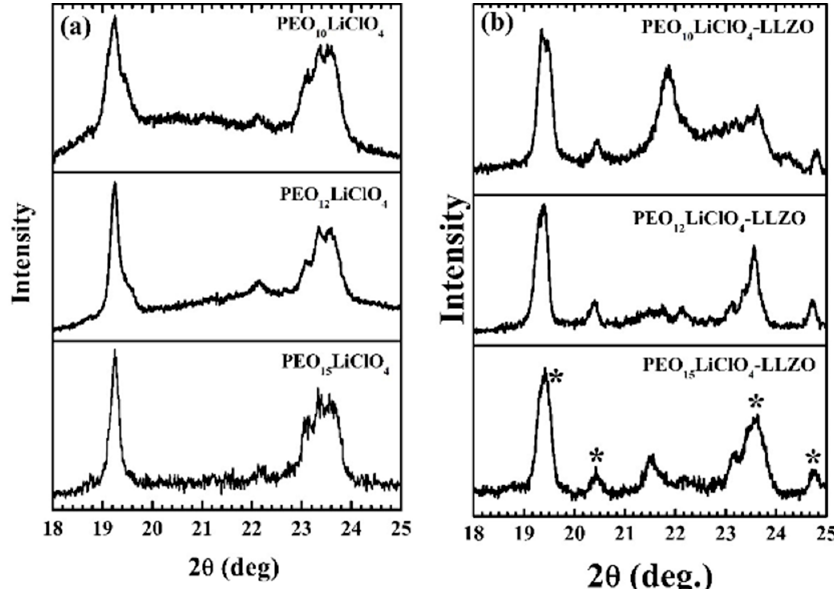
Figure 1. ( a ) XRD patterns of PEO n LiClO 4 and ( b ) XRD patterns of PEO n LiClO 4 -LLZO. LLZO peaks are marked with asterisks.